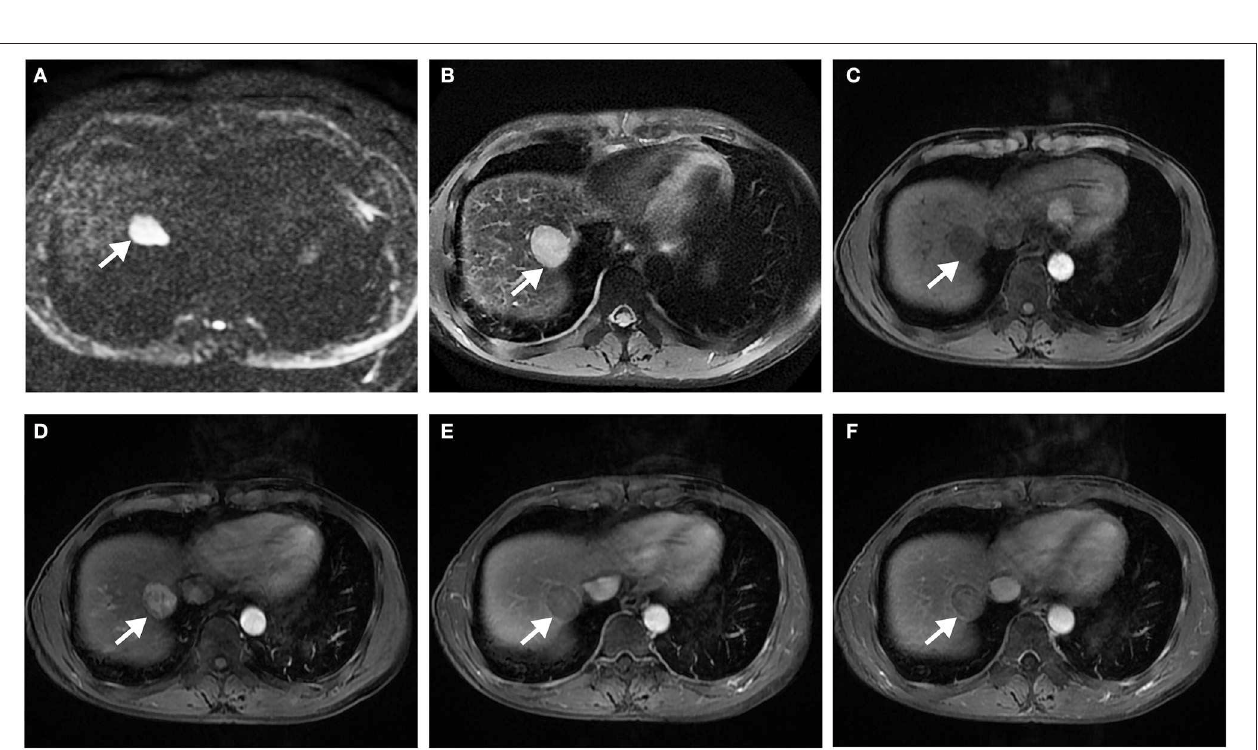
FIGURE 5 | Surgically confirmed moderately differentiated HCC with AFP = 3ng/mL. MR imaging showed a hepatic nodule (2.9cm, arrow) in S7/8 with restricted diffusion (A) and mild-moderate T2 hyperintensity (B) . The nodule is hypointense on precontrast T1WI (C) and shows hyperenhancement, without corona enhancement in late arterial phase (D) , smooth tumor margin in portal venous (E) , and delayed (F) phase. Histology confirmed MVI ( + ). This patient did not have any recurrence after resection during the 37 months follow-up period.